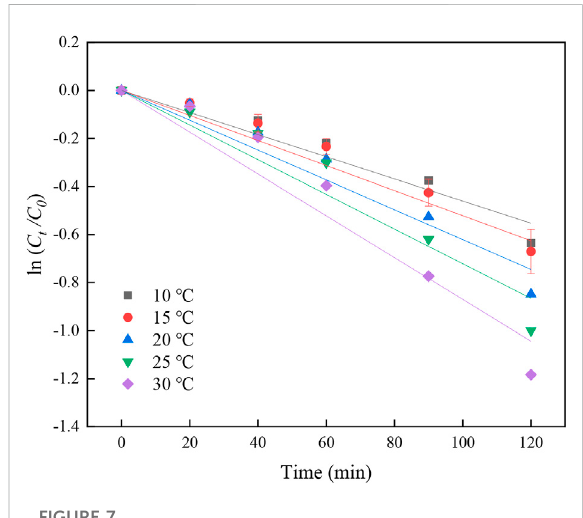
FIGURE 7 Effect of temperature on photodegradation of acid orange 8 by NCM.